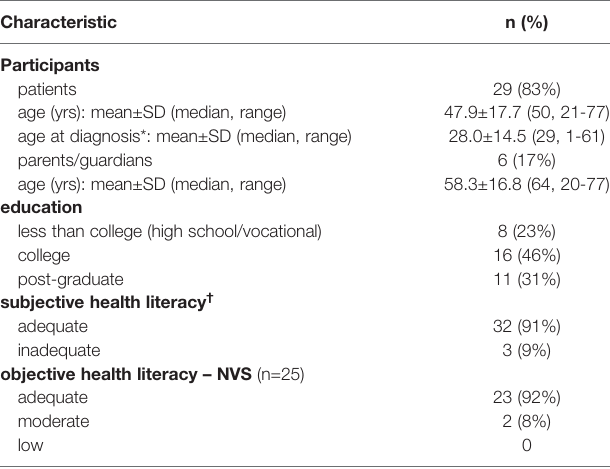
TABLE 2 | Demographic characteristics of participants evaluating the KS transition passport